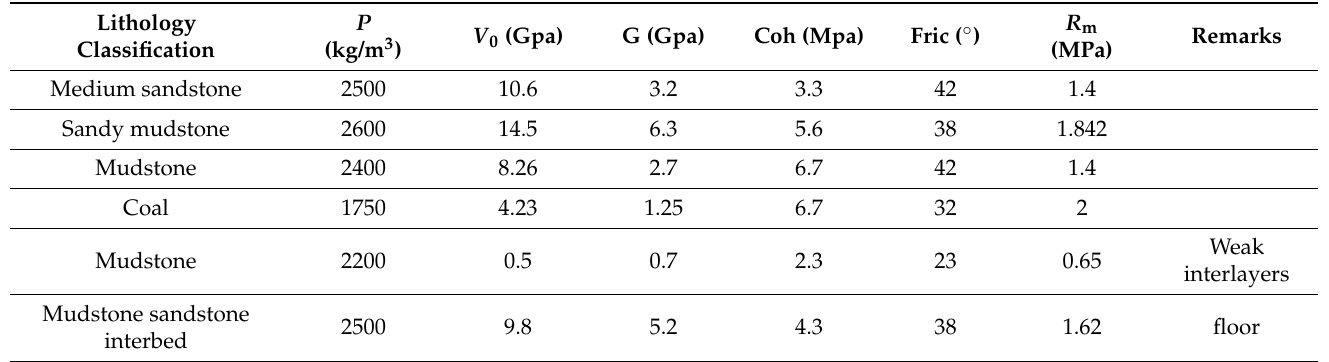
Table 1. Mechanical Parameters of Surrounding Rock Materials.